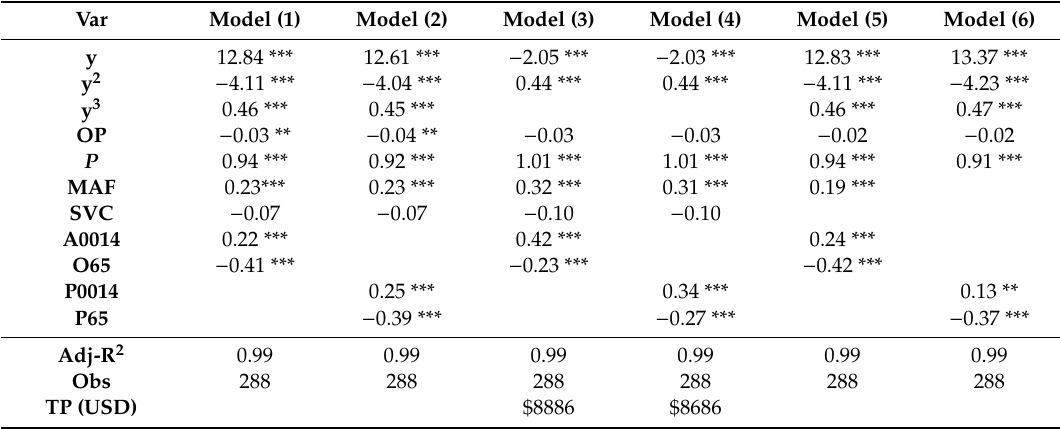
Table 7. Panel fully modified ordinary least squares (FMOLS) estimation